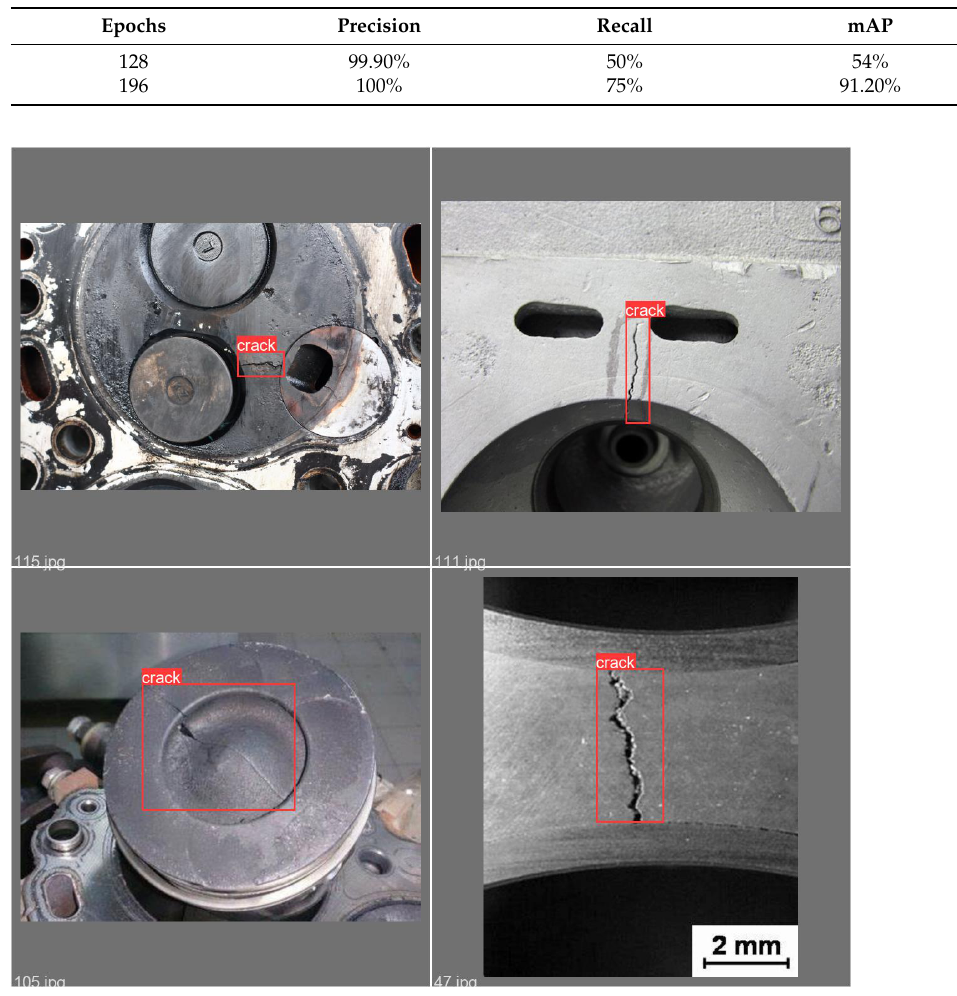
Figure 11. Sample images of cracks detected using